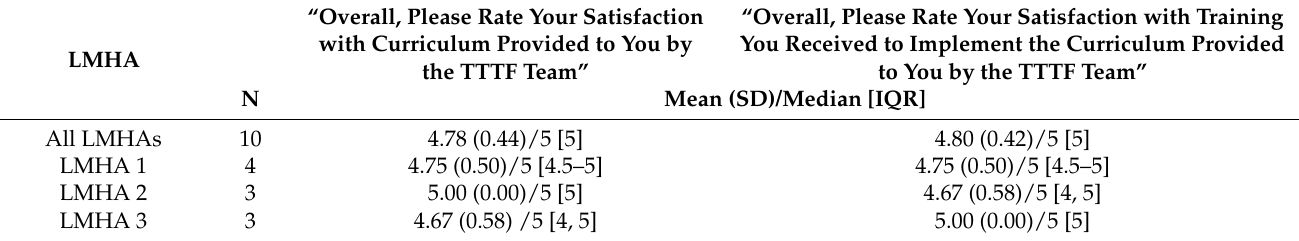
Table 6. Champion Ratings of TTTF-provided Curriculum and